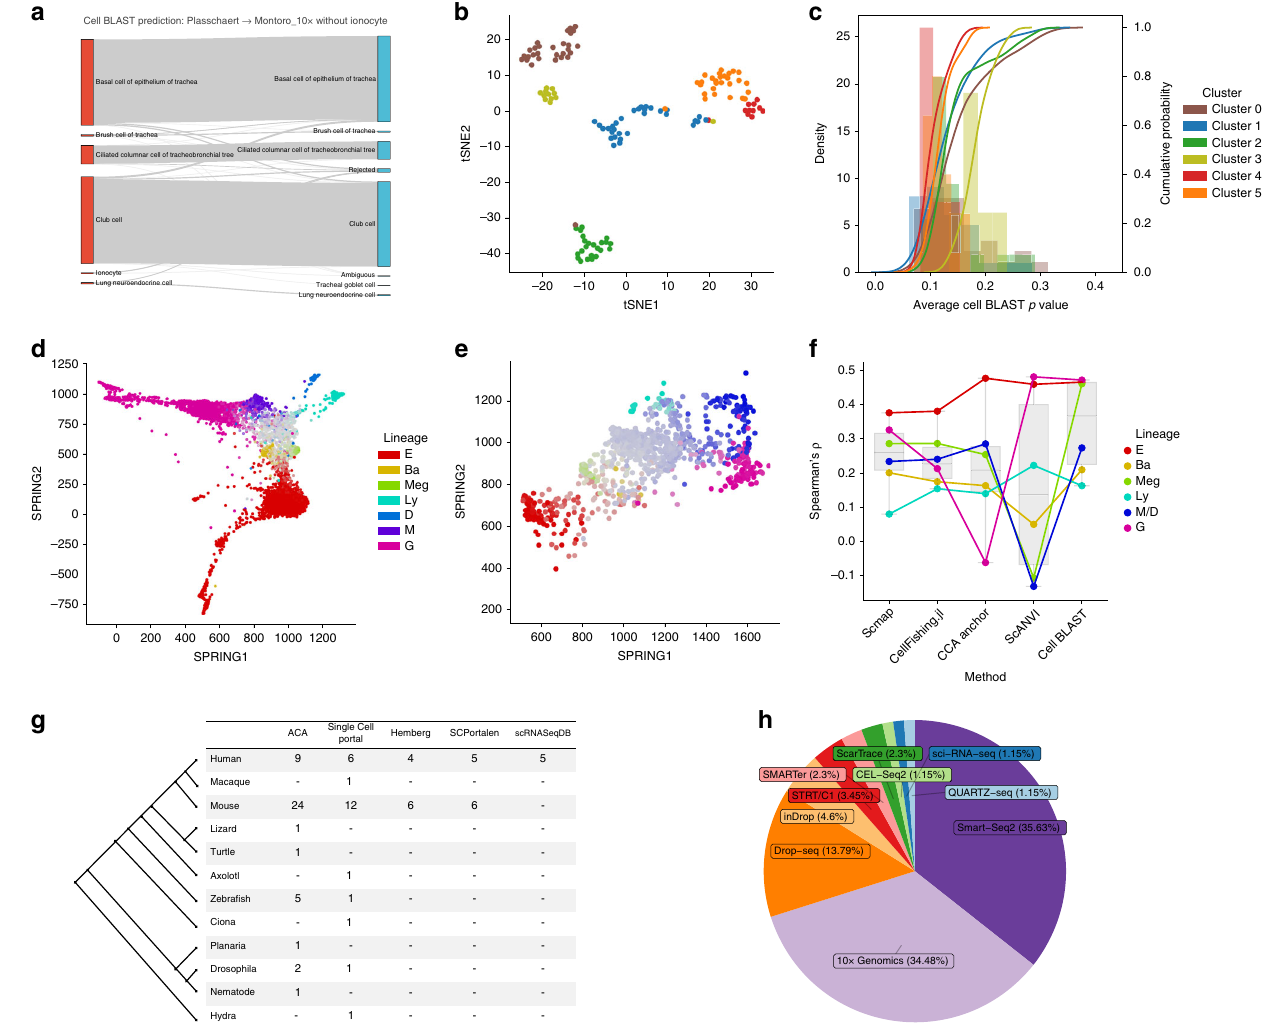
Fig. 3 Cell BLAST application. a Sankey plot comparing Cell BLAST predictions and original cell-type annotations for the “ Plasschaert ” dataset. b tSNE visualization of Cell BLAST-rejected cells, colored by unsupervised clustering. c Average Cell BLAST empirical P -value ( “ Methods ” ) distribution of each cluster in ( b ). d SPRING visualization of cell embeddings learned on the “ Tusi ” dataset, colored by cell fate. Each of the seven terminal cell fates (E erythroid, Ba basophilic or mast, Meg megakaryocytic, Ly lymphocytic, D dendritic, M monocytic, G granulocytic neutrophil) is assigned a distinct color. The hue of each cell is then determined by the lineage with largest probability, while the saturation of each cell is determined by the entropy of cell fate distribution, i.e., terminally committed cells have more vibrant colors while undifferentiated cells appear to be gray. e SPRING visualization of the “ Velten ” dataset, colored by Cell BLAST predicted cell fate. f Spearman correlation between predicted cell fate probabilities and expression of known lineage markers in the “ Velten ” dataset ( n = 6 lineages, where M and D are merged as they are indistinguishable in “ Velten ” according to the original publication). Box plots indicate the median (center lines), 1st and 3rd quartiles (hinges), minimum and maximum (whiskers). g Number of organs covered in each species for different single-cell transcriptomics databases, including the Single Cell Portal (https://singlecell.broadinstitute.org/single_cell), Hemberg collection 2 , SCPortalen 23 , and scRNASeqDB 24 . h Composition of different single-cell sequencing platforms in